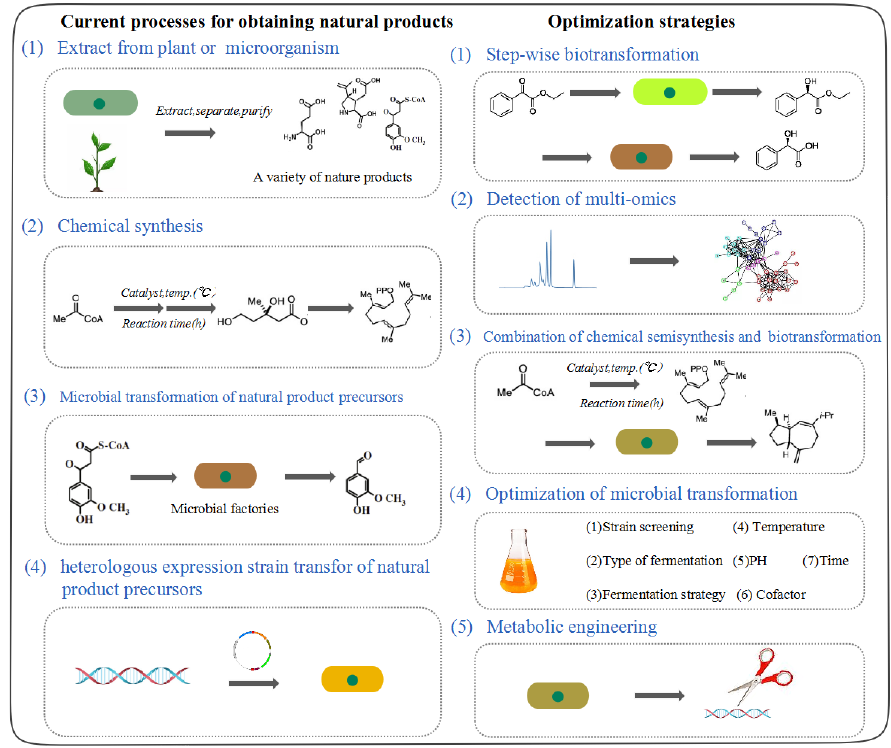
Figure 1. Current processes for obtaining natural products: (1) Extract natural products from plants or microorganisms. (2) Chemical synthesis of natural products. (3) Microbial transformation of natural product precursors. (4) Transformation of natural product precursors by heterologous expression strains. Multiple optimization strategies: (1) Multi-step microbial transformation of natural products. (2) Multi-omics detection of natural products transformed by microorganisms. (3) Combination of chemical semisynthesis and biotransformation. (4) Optimize the conditions of microbial transformation process, including strain screening, type of fermentation, fermentation strategy, temperature, pH, and co-factor. (5) Metabolic engineering changes the transformation ability of microbial strains for the purpose of alleviating feedback inhibition, reducing cytotoxicity, increasing metabolic flow, reducing by-products, and increasing precursor